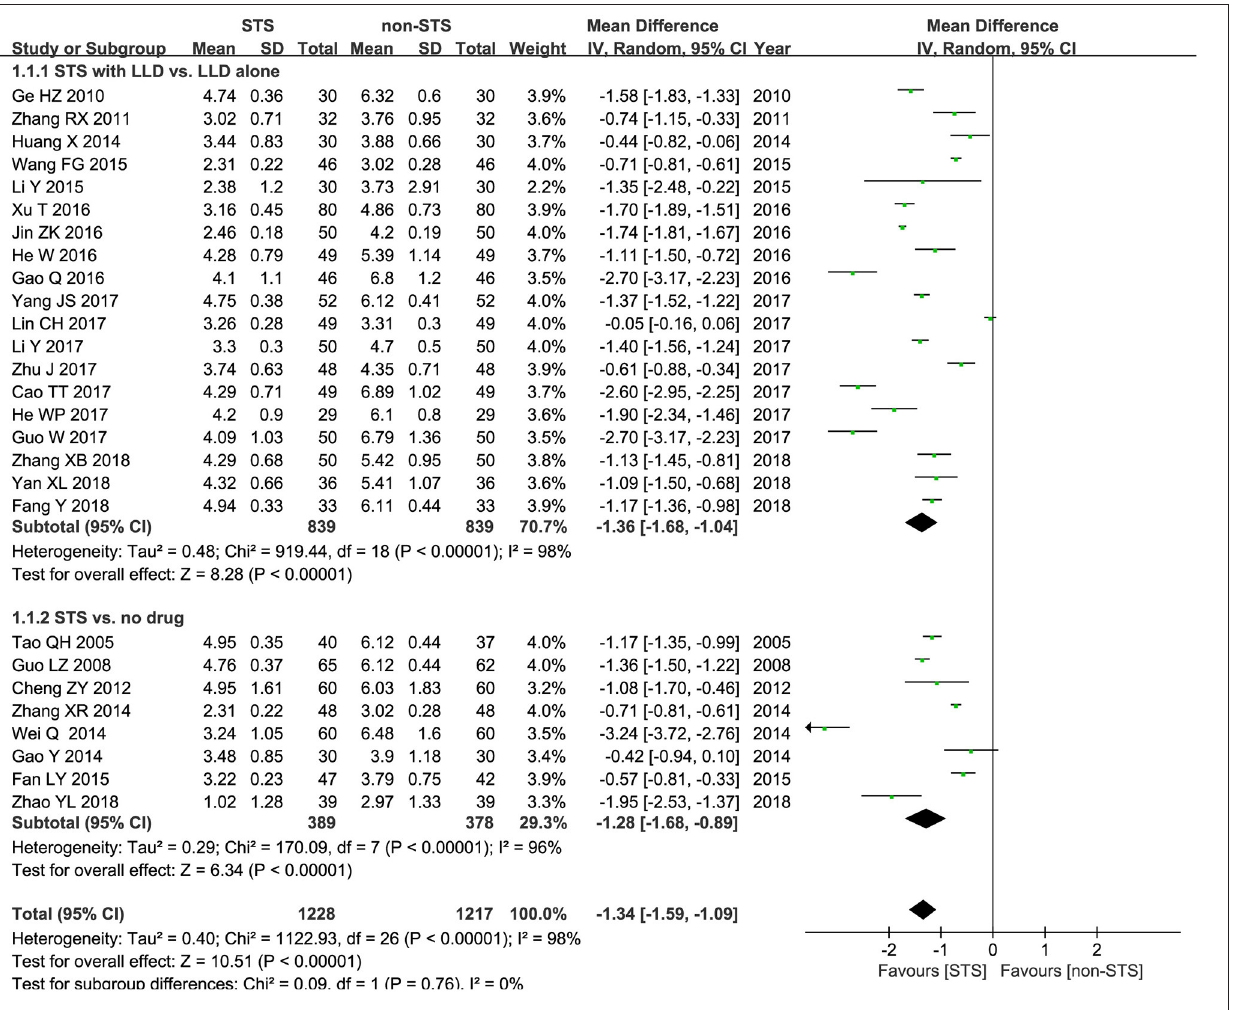
FIGURE 3 | Forest plot of comparison: STS vs. non-STS in TC.